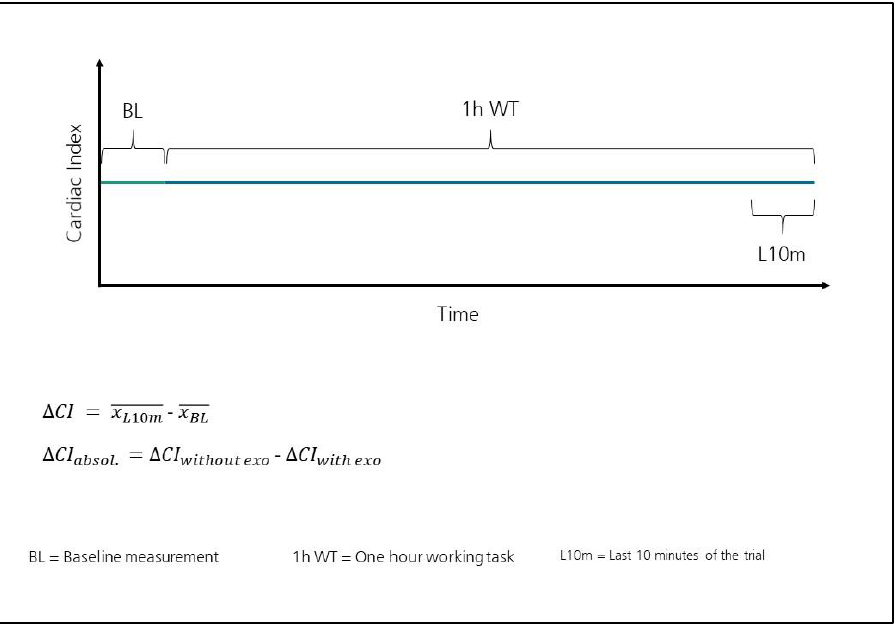
Figure 5. Schematic representation of the data preparation. Fraunhofer IPA.